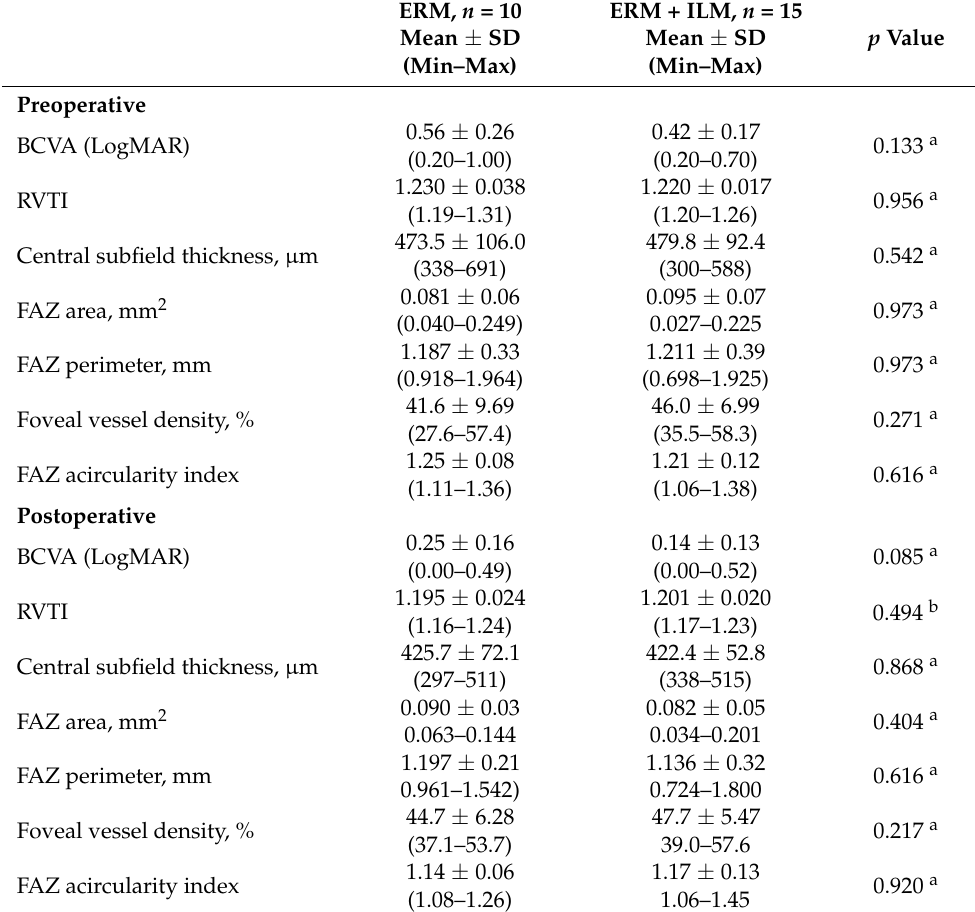
Table 2. Comparison of the preoperative and postoperative mean best corrected visual acuities, retinal vascular tortuosity indices, central subfield thicknesses, and FAZ parameters in patients according to the additional internal limiting membrane peeling.